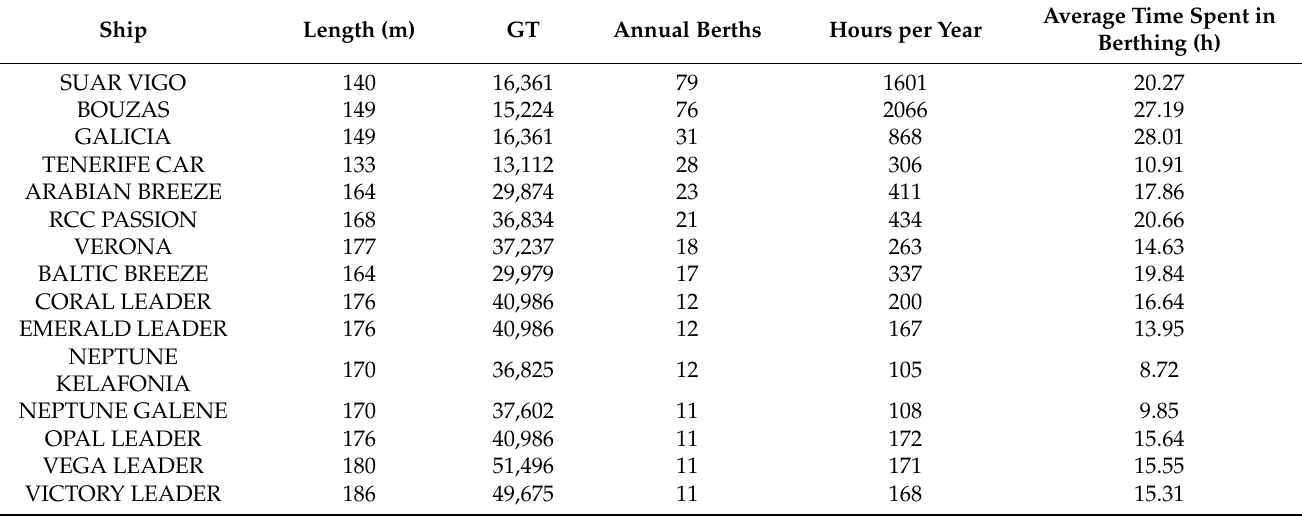
Table A2. Ro–Ro ships selected in the PAV Report